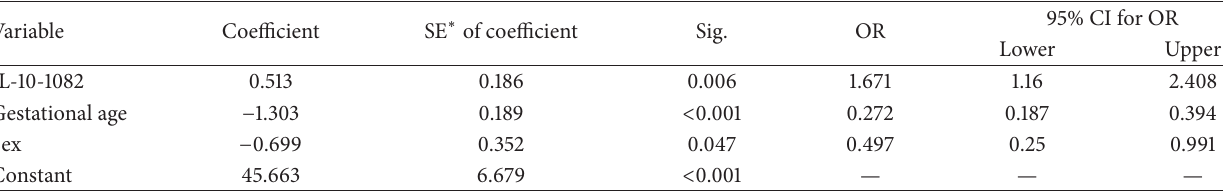
Table 5: Result of logistic regression for dependent variable of